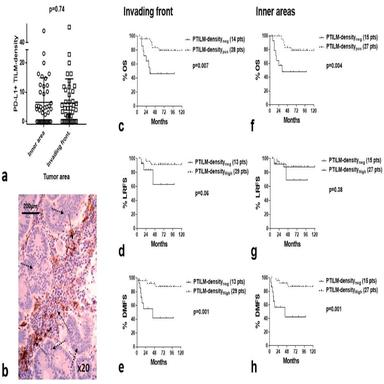
PD-L1+ lymphocytes and monocytes infiltrating the tumor stroma (PTILM-density) analysis: (a) Distribution of PTILM-density in inner tumor areas and the invading tumor front; (b) Typical immunohistochemical image of PD-L1 expression by inflammatory (lymphocytes and monocytes) cells infiltrating the tumor stroma (black arrows) in the context of negative cancer cell PD-L1 expression (dotted arrows); (c) Kaplan-Meier overall disease-specific survival (OS) according to PTILMdensity in the invading tumor front; (